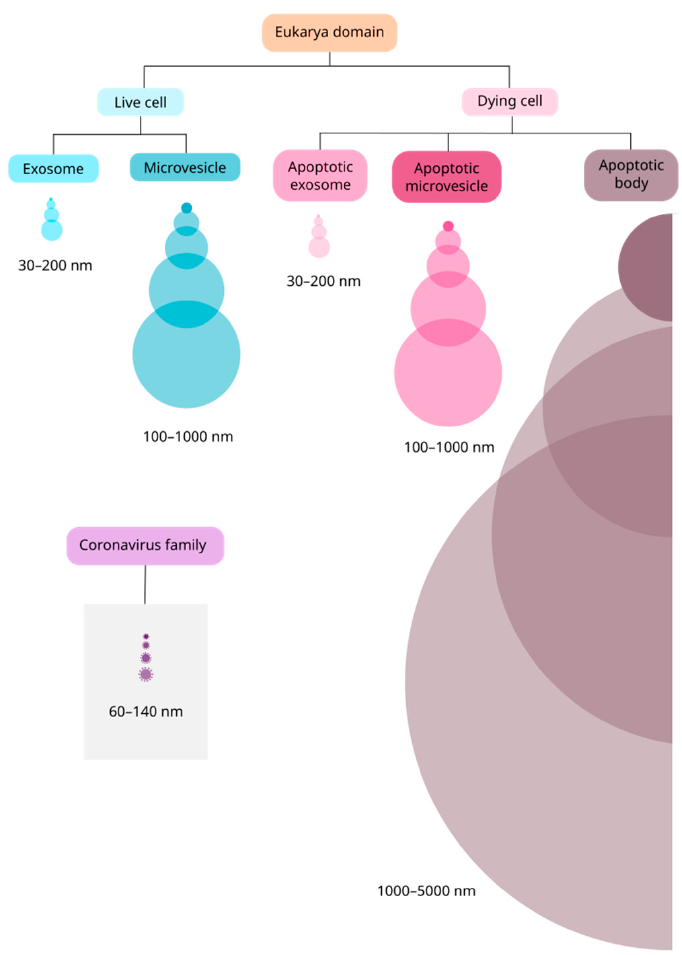
Figure 1. Size comparison between EVs and the coronavirus family. In the Eukarya domain, EVs are secreted by virtually all types of cells, live or dying. Between live cells, there are two main subtypes of vesicles: exosomes and microvesicles. Among cells undergoing apoptosis, there are three main subtypes: apoptotic exosomes (ApoExo), apoptotic microvesicles (ApoMV) and apoptotic bodies. ApoExo and ApoMV were recently described and may have similar size to their correspondents in live cells. The vesicles and the virus are represented proportionally in